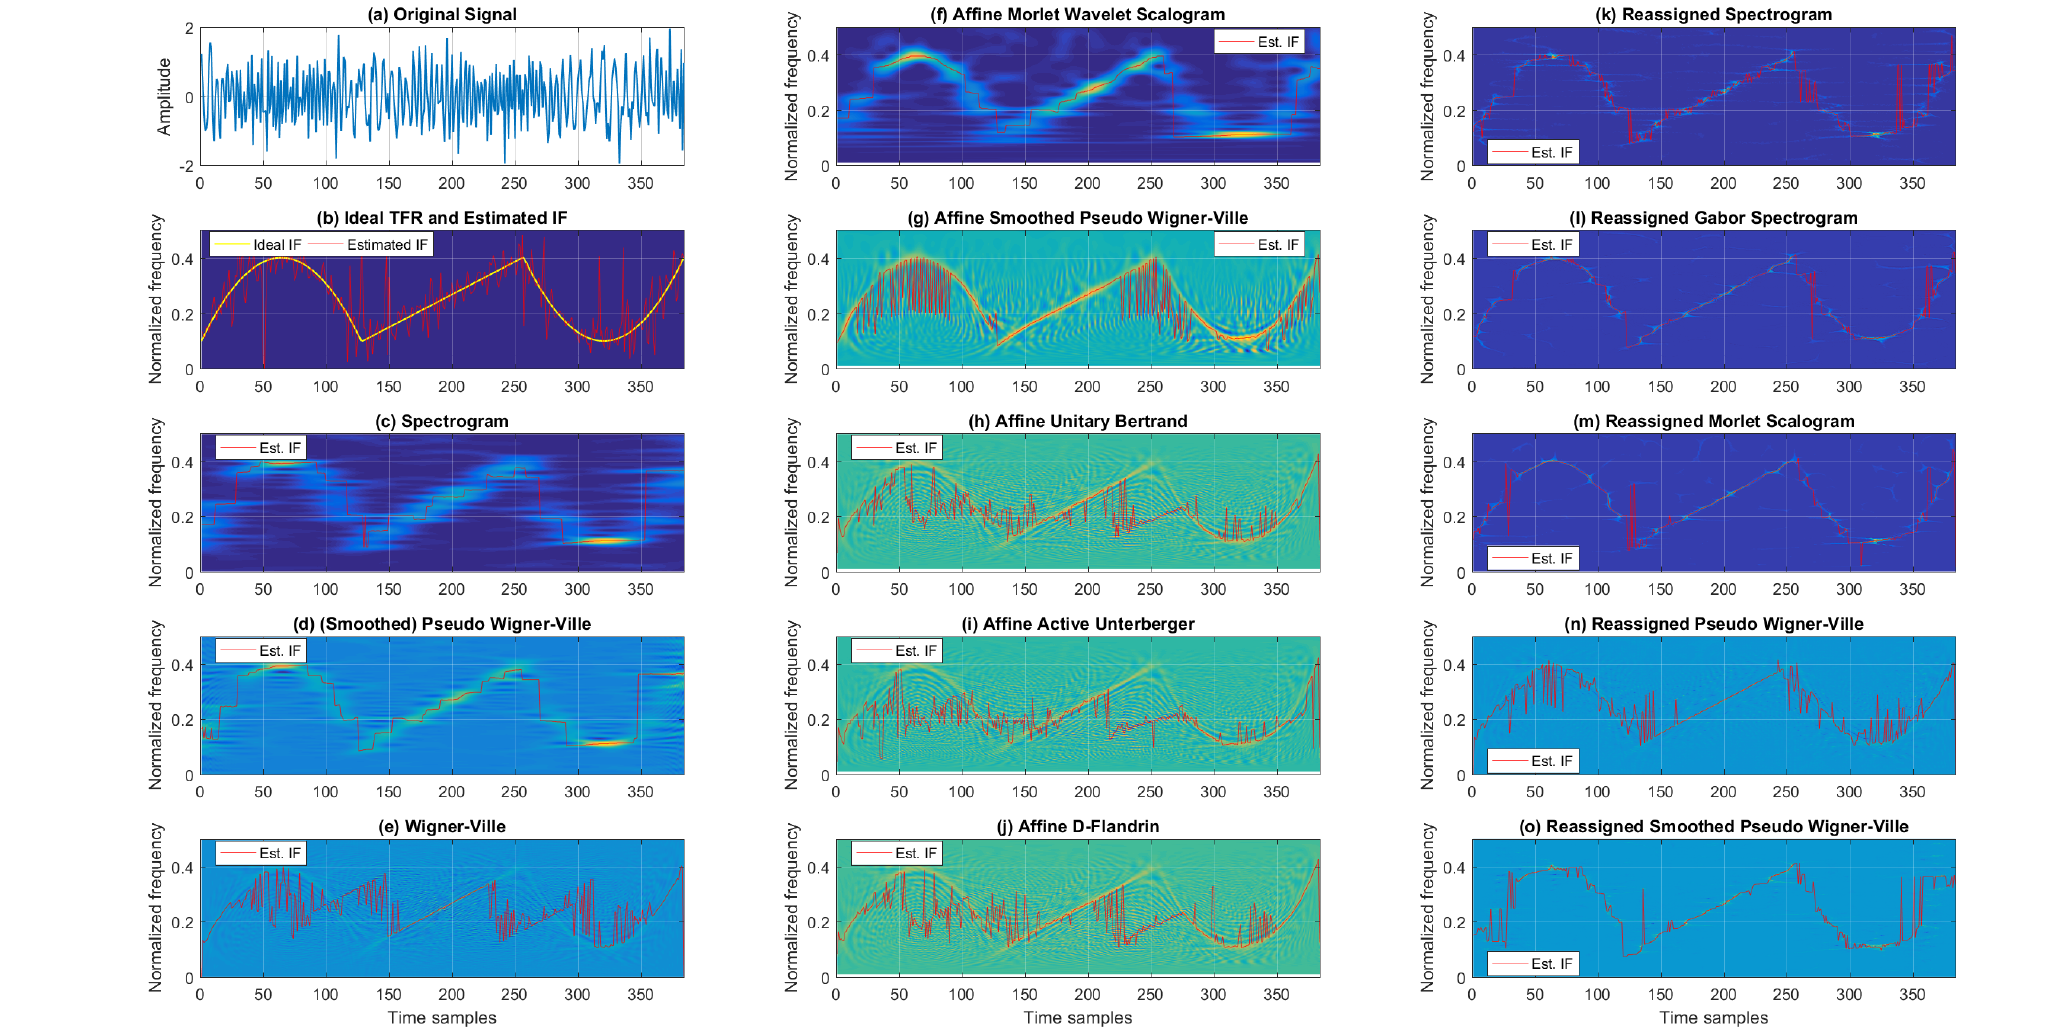
Figure 5. TFRs of a noisy multi-component signal with successive parabolic and linear FM components for 5 dB